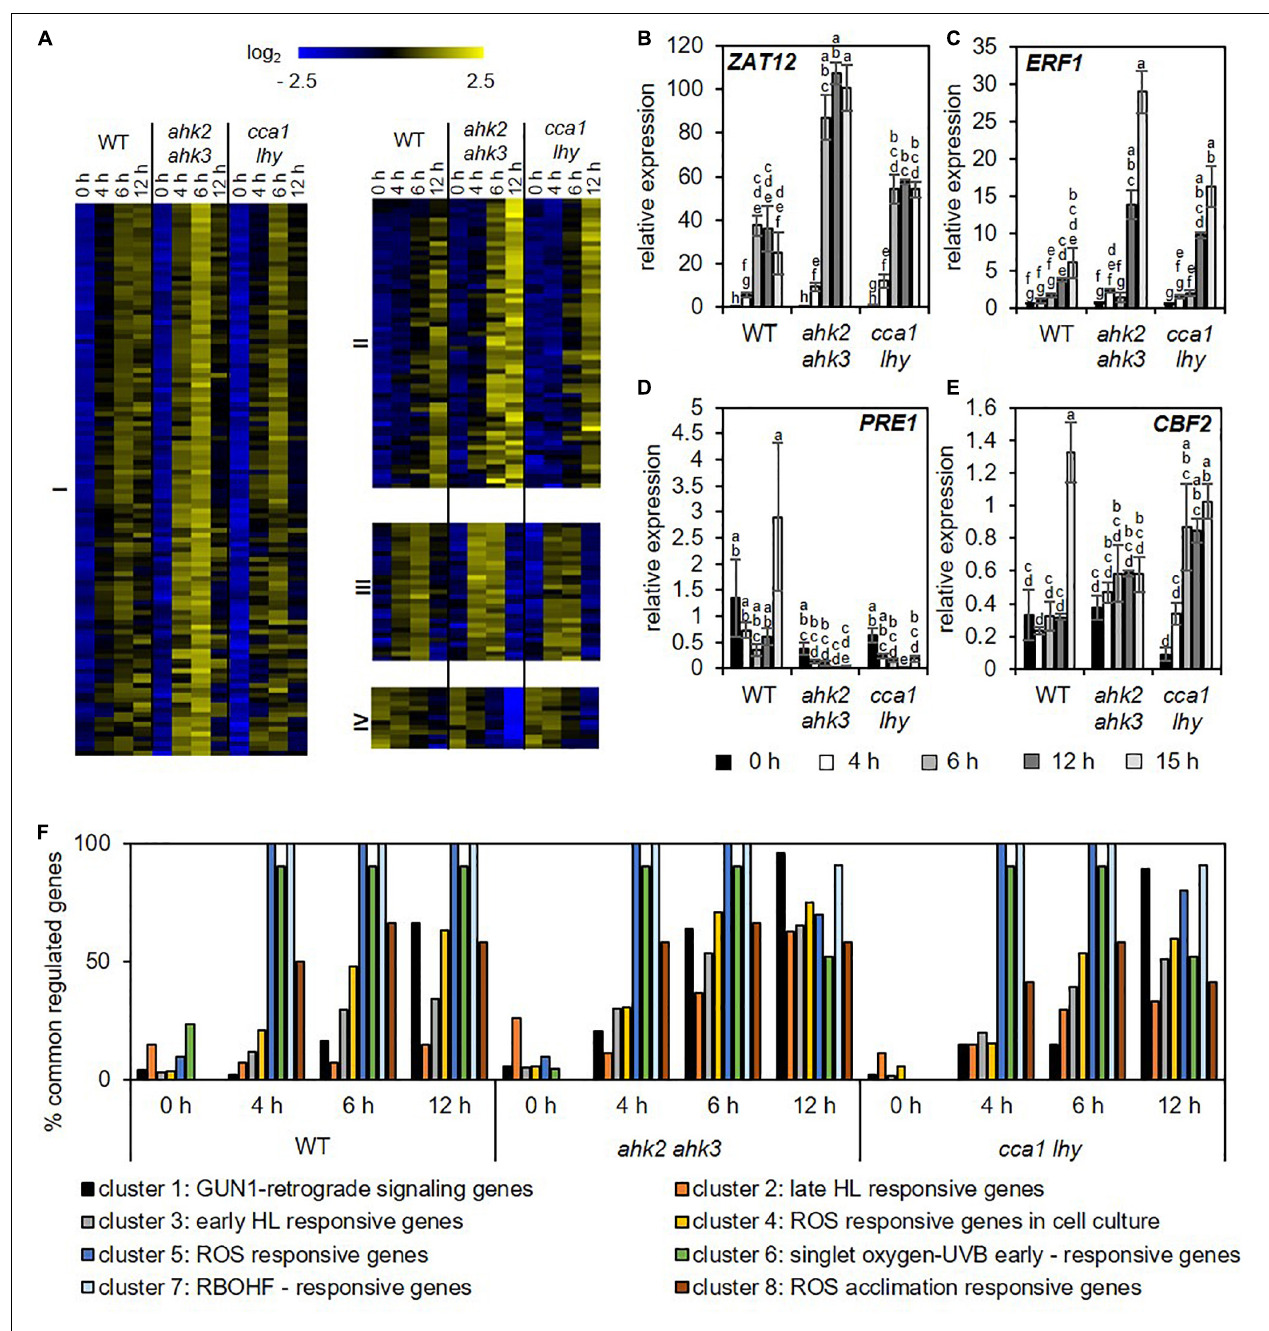
FIGURE 4 | Photoperiod stress is associated with a strong transcriptional regulation of genes involved in oxidative stress. (A) QT clustering of log 2 fold change to corresponding control of genes encoding TFs identified by Gadjev et al. (2006), Lai et al. (2012), Hieno et al. (2019) and Zandalinas et al. (2019), and as ROS-responsive genes. The overlap of the genes identified in the different studies is shown in Supplementary Figure 3 . Four different clusters (I–IV) were identified. An overview of the regulation of these ROS responsive genes after exposure to a prolonged light period (PLP) are provided in Supplementary Data 3 . (B–E) Relative expression of representative genes of each of the four cluster shown in (A) , i.e., ZAT12 (B) , ERF1 (C) , PRE1 (D) , and CBF2 (E) in WT, ahk2 ahk3 and cca1 lhy plants during the night following the 32 h PLP measured by qRT-PCR. Only results for PLP-treatment are shown. An overview of all expression levels including control conditions are provided in Supplementary Table 12 . All values are expressed relative to 0 h WT control which was set to 1. Error bars represent SE ( n ≥ 3). Letters indicate different statistical groups as determined by ANOVA followed by Tukey’s post-hoc test. (F) Percentage of photoperiod stress-responsive genes that are co-regulated with the genes of the ROS wheel as defined by Willems et al. (2016). An overview of the regulation of these transcriptome profiles after photoperiod stress is given in Supplementary Data 5 .